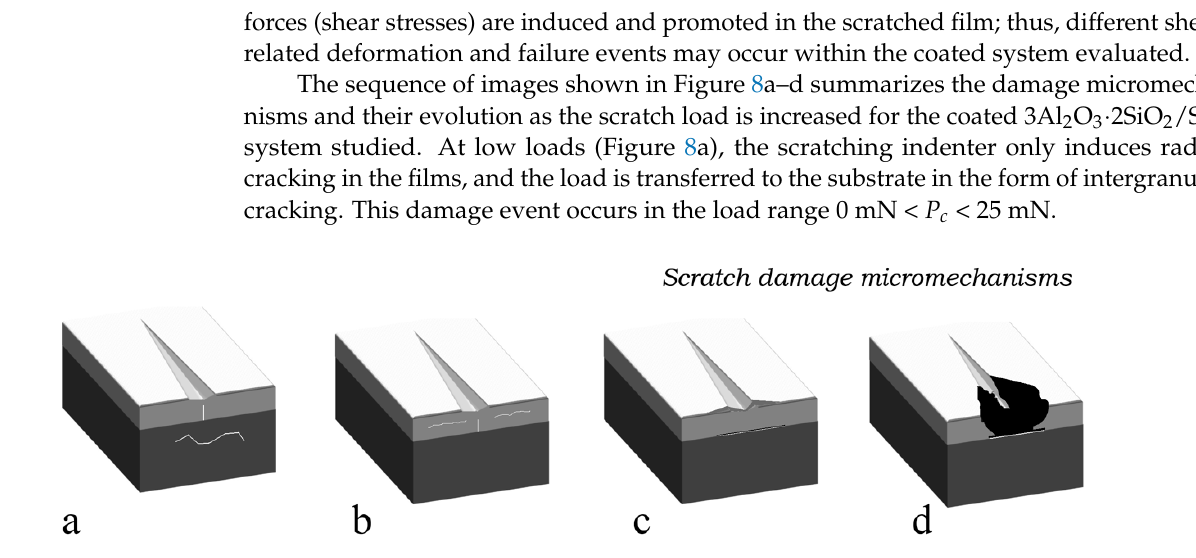
Figure 8. Scratch damage micromechanisms under increasing load tests. Radial cracking within the films and intergranular cracking in SiC substrate ( a ), followed by lateral film cracking ( b ) which progresses to film delamination ( c ) and finally film chipping ( d ).